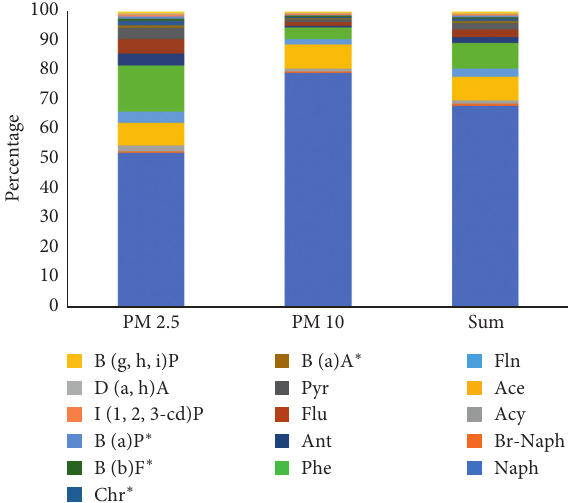
Figure 4: Distribution of individual PAHs in some kinds of particulate matter